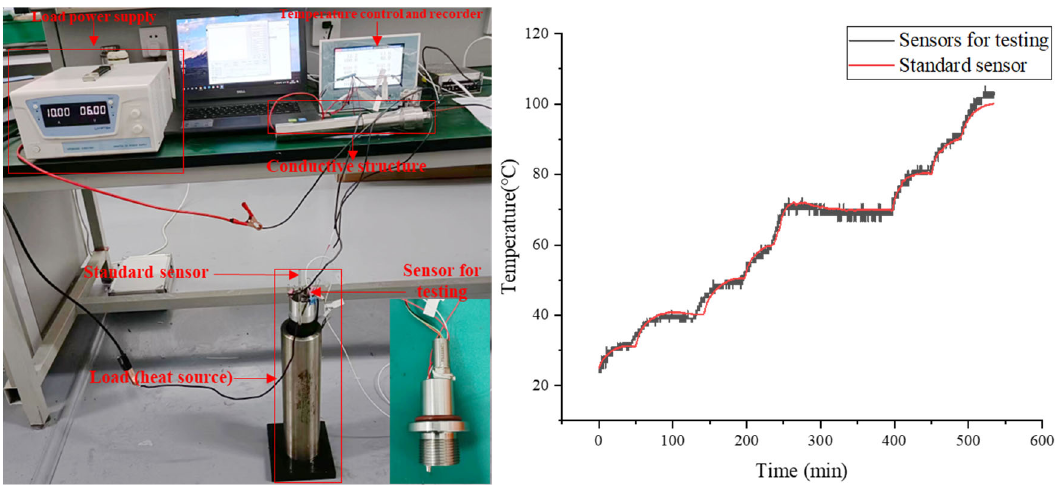
Figure 29. Comparison experiment and results of the temperature sensor testing.